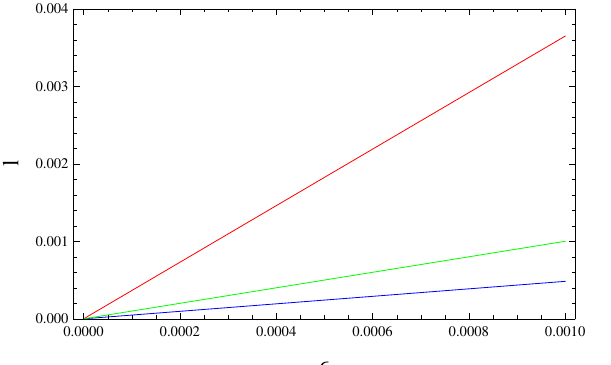
Figure 2. Graphical illustration of correspondence between proper length (cid:96) (km) and the shell thickness (cid:101)